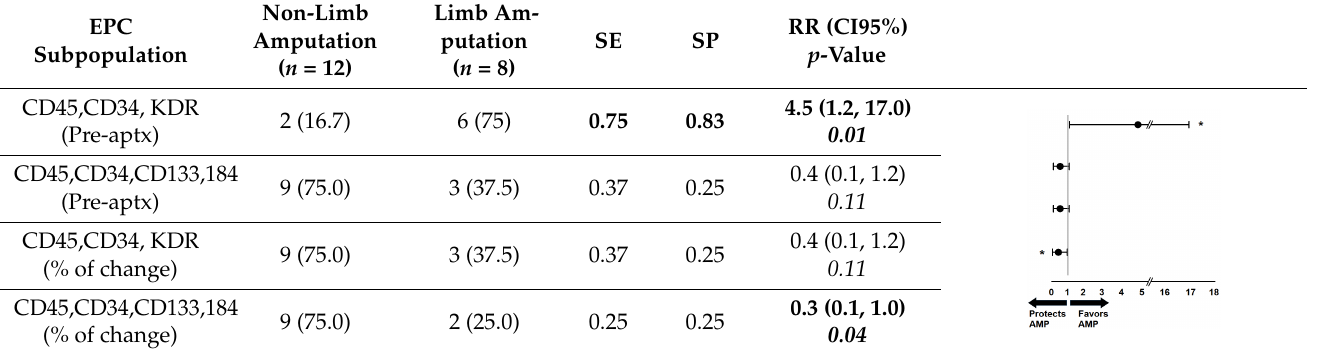
Table 3. Associated